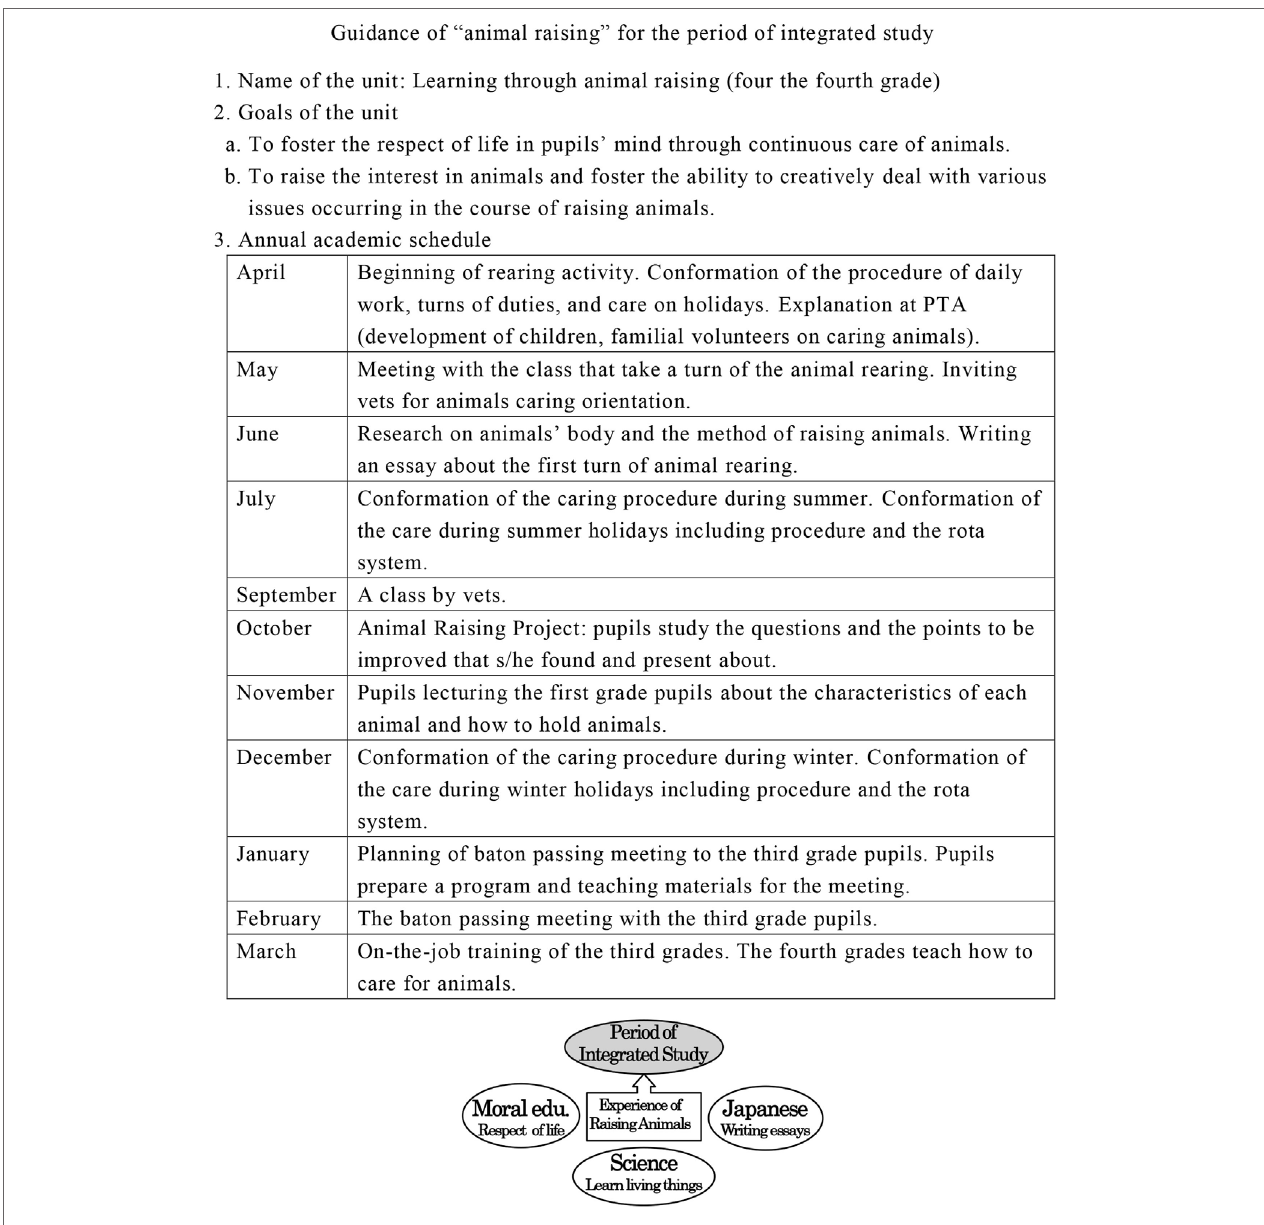
FiGURe 1 | Annual educational plan of PIS using animal rearing as an educational tool. Source: data adapted from Ref.